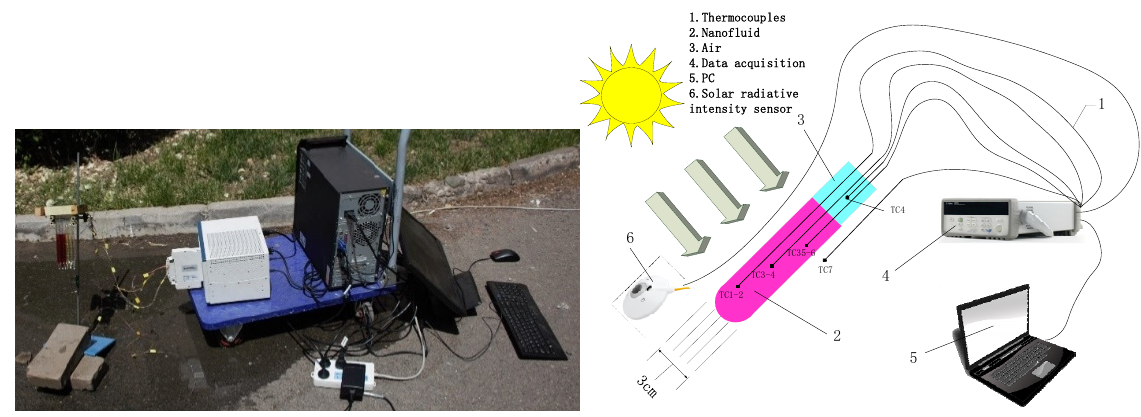
Figure 9. Experimental Setup and diagram of the experimental setup.